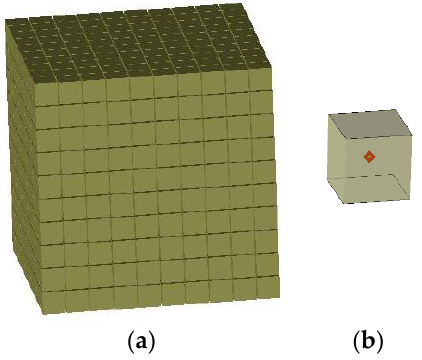
Figure 1. Attribute block model. ( a ) Discreted block model; ( b ) Attribute hexahedron and center